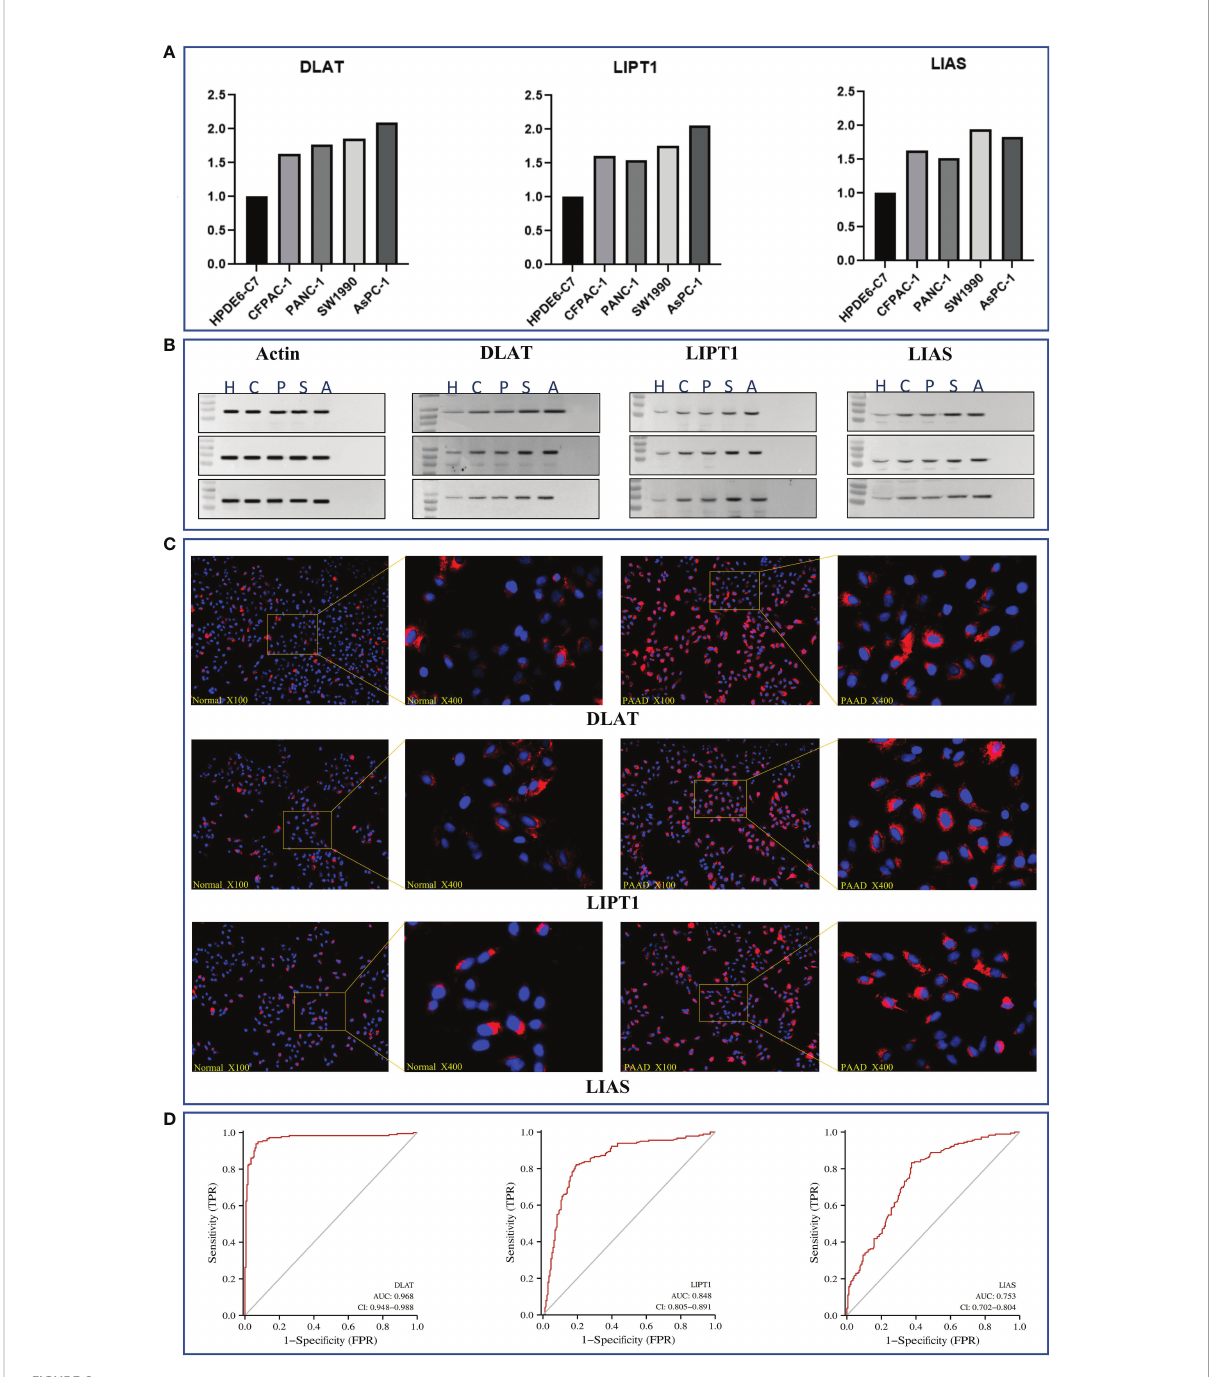
FIGURE 8 In-vitro validation of essential genes (i.e., DLAT, LIPT1 , and LIAS ) as potential diagnostic biomarkers in PAAD. (A) Results of RT-qPCR of DLAT, LIPT1 , and LIAS in HPDE6-C7, CFPAC-1, PANC-1, SW1990, and AsPC-1 cell lines, respectively. (B) Results of western-blot in triple repletion utilizing the aforementioned cell lines. (C) IFS slides in 100X and 400X magni fi cation demonstrated the expressional abundance of these proteins of interest in HPDE6-C7 and AsPC-1 cell lines. (D) Evaluation of the eligibilities of DLAT, LIPT1 , and LIAS serving as diagnostic biomarkers in